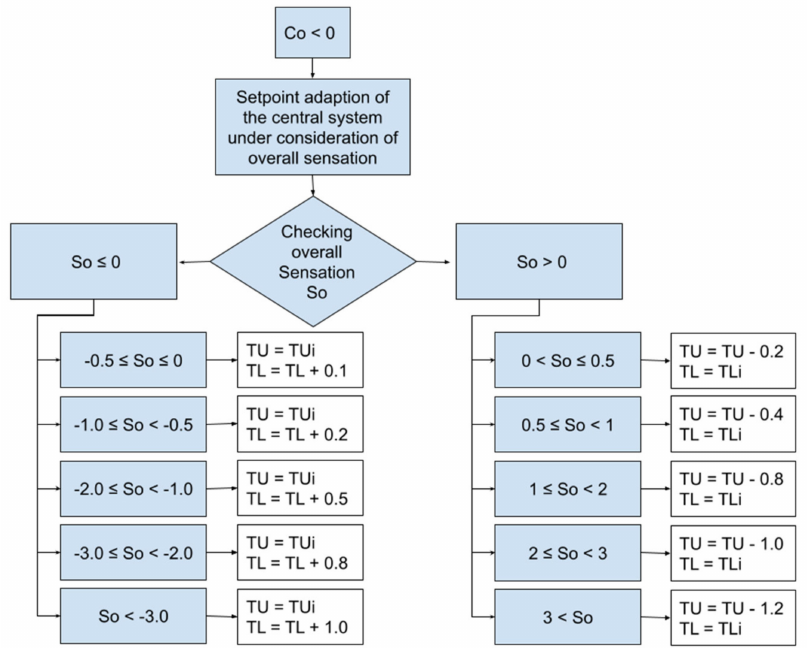
Figure 7. Detailed control logic based on Figure 6; in the case of a negative comfort value (Co < 0), the setpoints are adapted according to the overall sensation value